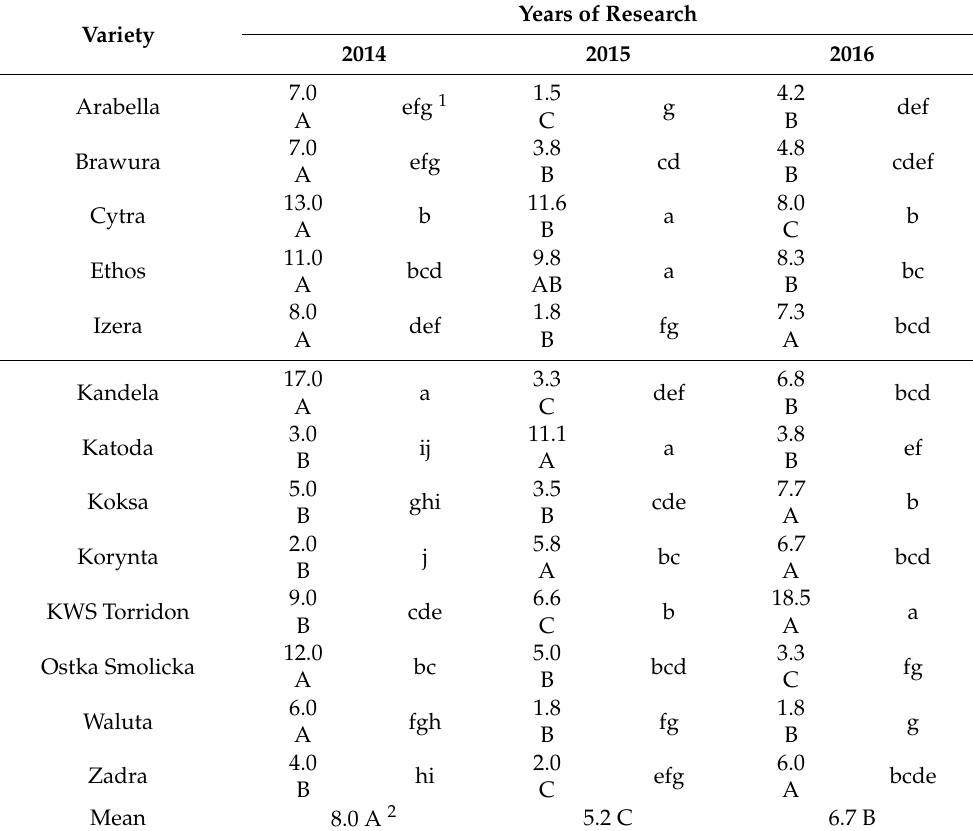
Table 4. The infestation of the grains (%) of spring wheat varieties. Variety